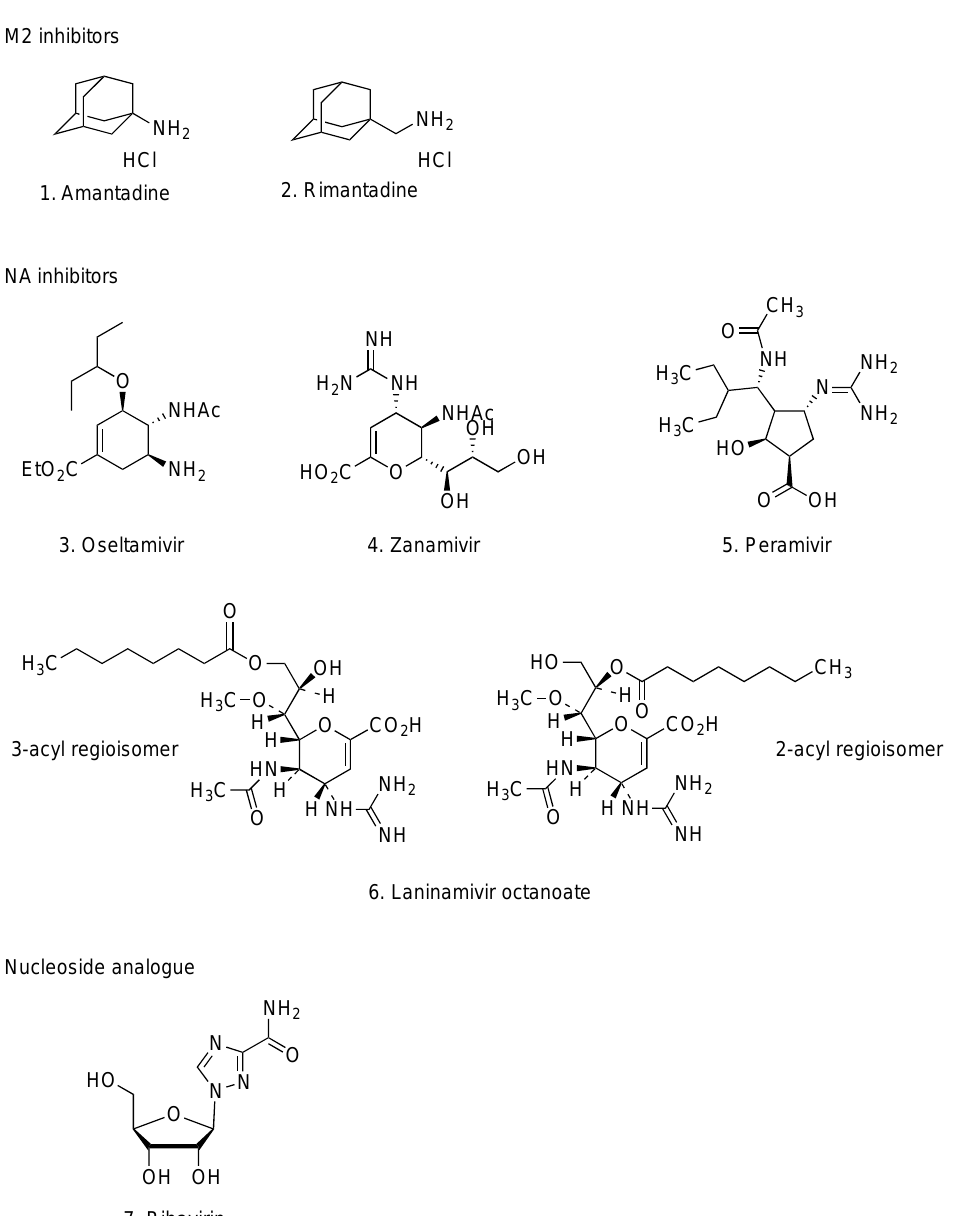
Figure 1. Current available anti-influenza